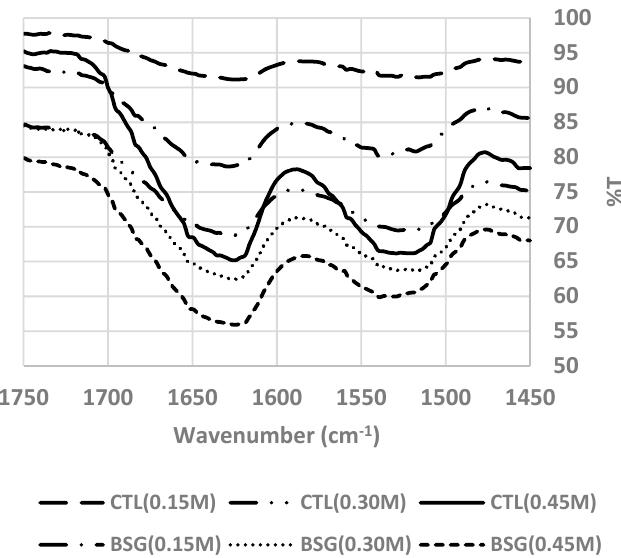
Figure 3. FTIR (wavenumber 1750–1450 cm − 1 ) of myofibrillar protein with basil seed gum at different salt concentrations. Treatments: CTL(0.15 M), myofibrillar protein mixtures (MP) without basil seed gum (BSG) at 0.15 M salt concentration; CTL(0.30 M), MP without BSG at 0.30 M salt concentration; CTL(0.45 M), MP without BSG at 0.45 M salt concentration; BSG(0.15 M), MP with BSG at 0.15 M salt concentration; BSG(0.30 M), MP with BSG at 0.30 M salt concentration; BSG(0.45 M), MP with BSG at 0.45 M salt concentration.